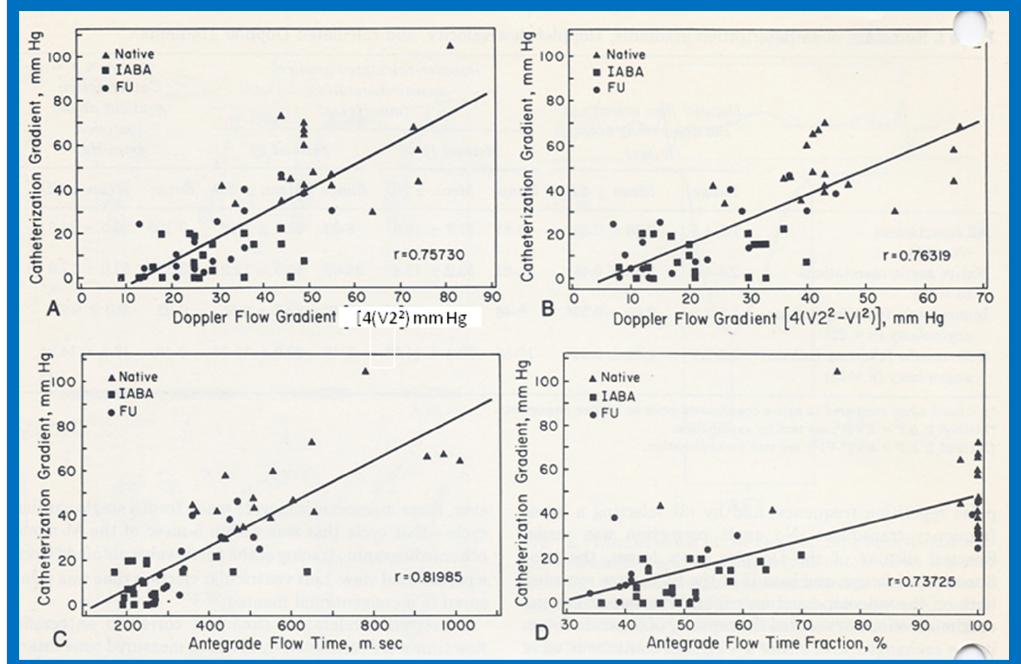
Figure 56. Linear regression analysis of catheterization ‐ measured peak ‐ to ‐ peak and Doppler ‐ derived (modified Bernoulli equation) peak instantaneous gradients across aortic coarctation are shown in ( A ) and ( B ). Note the similar correlation coefficients irrespective of the inclusion of proximal Doppler velocities. Similar regression analysis of catheterization ‐ measured peak ‐ to ‐ peak gradients and antegrade flow time (milli seconds) ( C ) and antegrade flow time fraction (%) ( D ) show minimal increase in correlation coefficient ( r = 0.82) when antegrade flow time is used. Filled triangles: Native coarctations; Filled squares: coarctations immediately after balloon angioplasty (IABA); Filled circles: coarctations at follow ‐ up (FU). Reproduced from Rao P.S., Carey P. [18].